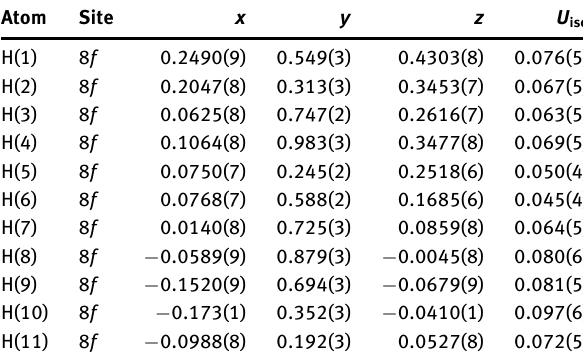
Table 2: Fractional atomic coordinates and isotropic or equivalent isotropic displacement parameters (Å 2